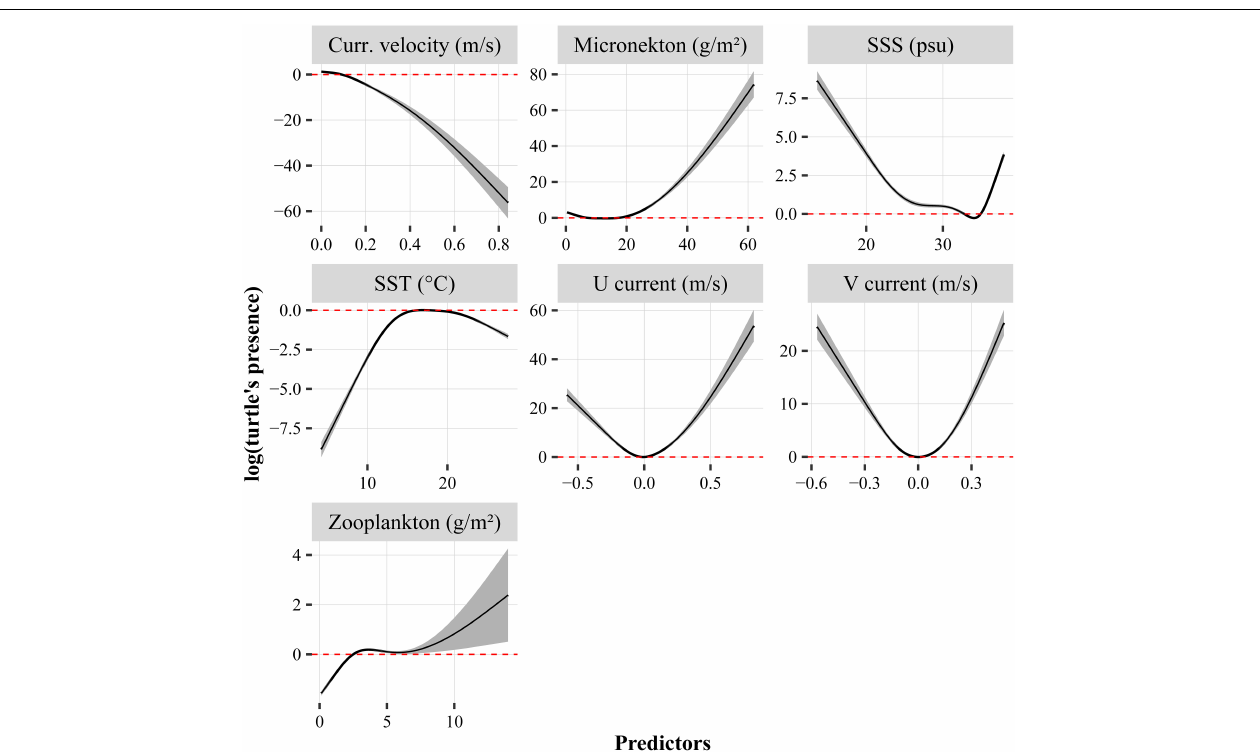
FIGURE 7 | Relationships between turtle’s presence ( y -axis) and their associated environmental variables obtained from the GAMs. The solid black line in each plot is the smooth function estimate and the shaded regions refer to the approximate 95% confidence intervals. The y -axis represents the response variable expressed in log scale. Positive values on the y - axis indicate a high probably of turtle’s presence, and conversely. The horizontal dotted lines indicate the probability of turtle presence is not significantly positively or negatively influenced by the predictor. SSS refers to Sea Surface Salinity.